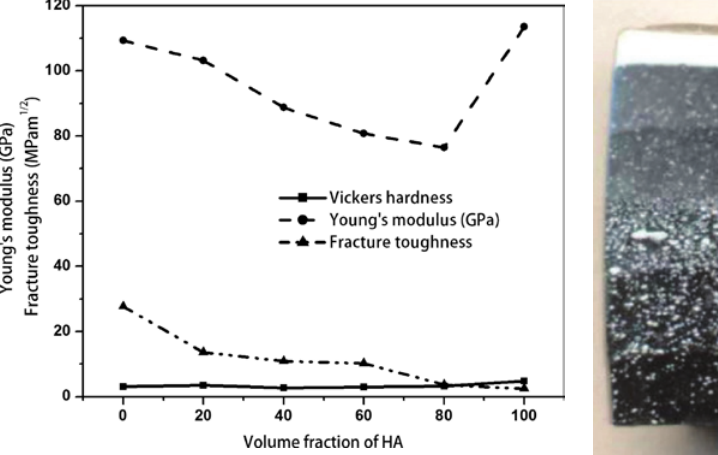
Figure 7: Effect of the volume fraction of HA on Young’s modulus, Vickers hardness, and fracture toughness of HA-Ti FGM [35].